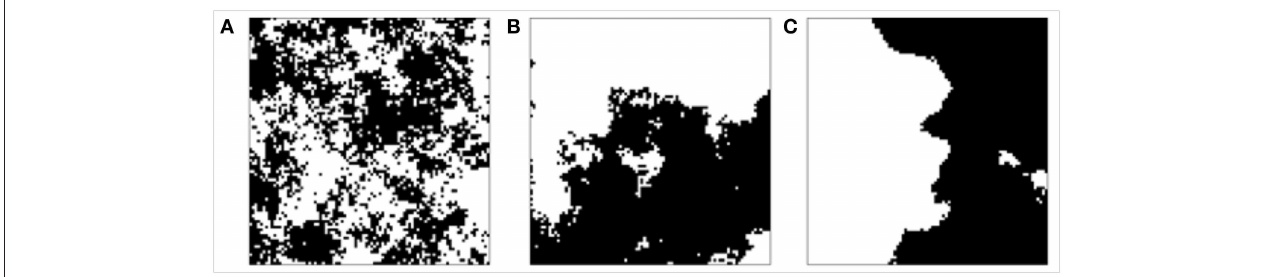
FIGURE 1 | Examples of disturbance patterns with fragmentation parameter 0 (A) , 0.5 (B) , and 1 (C) and disturbance size of 50% (black: disturbed area, white: undisturbed area).